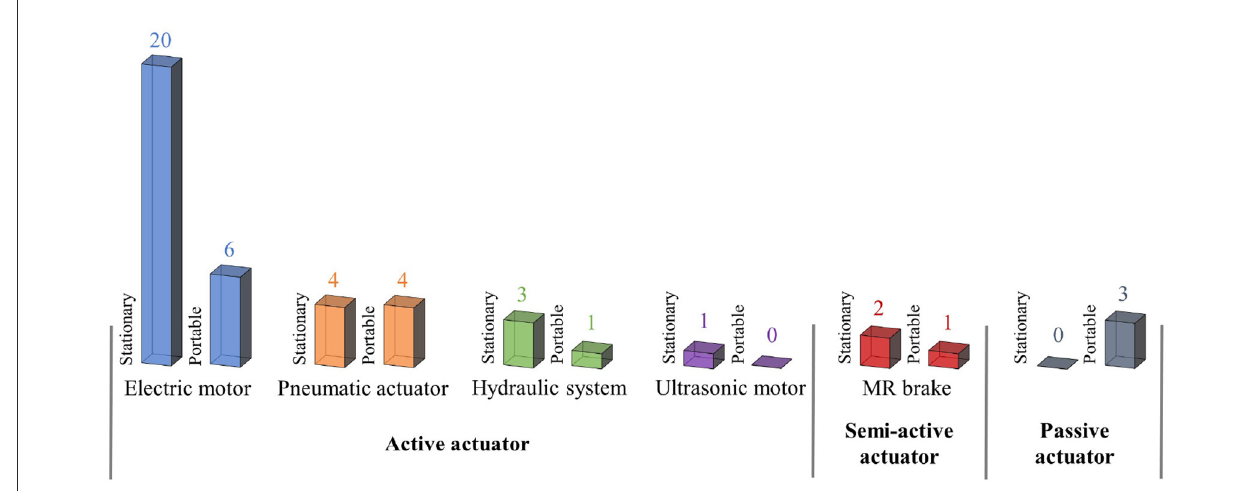
FIGURE3 Statistics of actuators used for stationary and portable upper limb exoskeleton (Manna and Dubey, 2018).